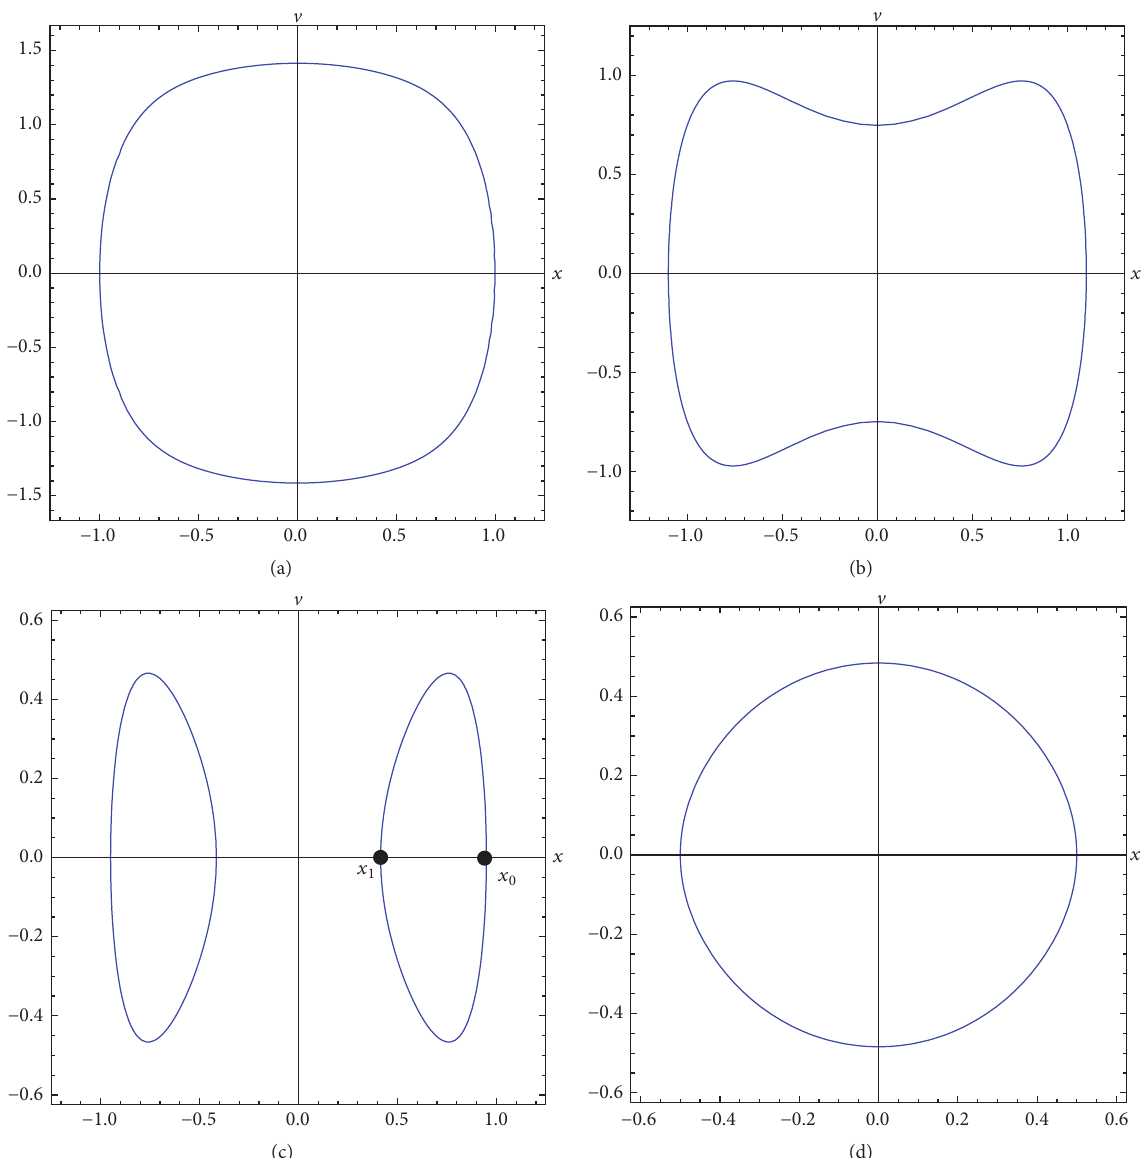
Figure 1: Phase space portraits for parameters values of (a) 𝑎 1 = 1 , 𝑎 5 = 3 , and 𝑥 0 = 1 ; (b) 𝑎 1 = −1 , 𝑎 5 = 3 , and 𝑥 0 = 1.1 ; (c) 𝑎 1 = −1 , 𝑎 5 = 3 , and 𝑥 0 = 0.95 ; and (d) 𝑎 1 = 1 , 𝑎 5 = −3 , and 𝑥 0 = 0.5 .